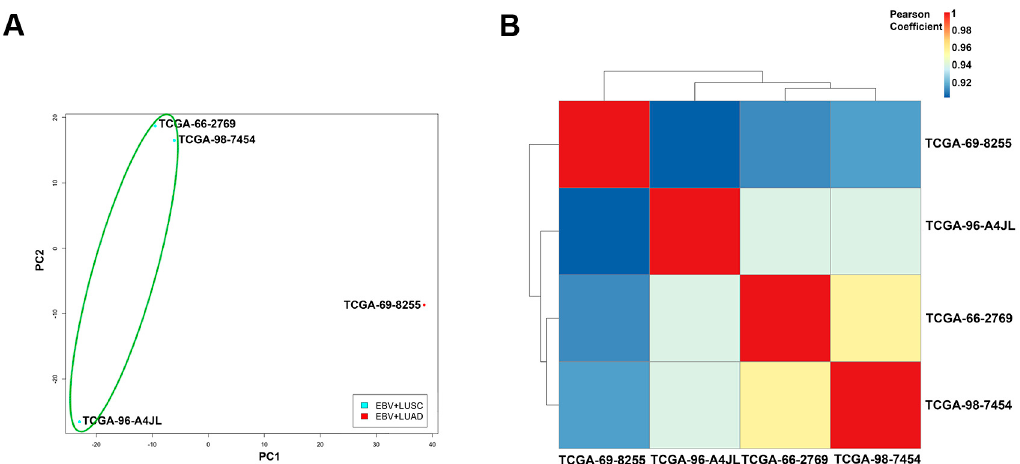
Figure 7. Dimension reduction, correlation and cluster analysis of cellular gene expression data of the EBV( + ) NSCLC. ( A ) Principal component analysis (PCA) of variability among EBV( + ) NSCLC samples based on cellular gene expression. Each point represents one sample, with color indicating sample groups as described in the figure legend. ( B ) Correlation analysis of the EBV( + ) NSCLC samples with the plot showing the correlation to the cellular gene expression pattern.